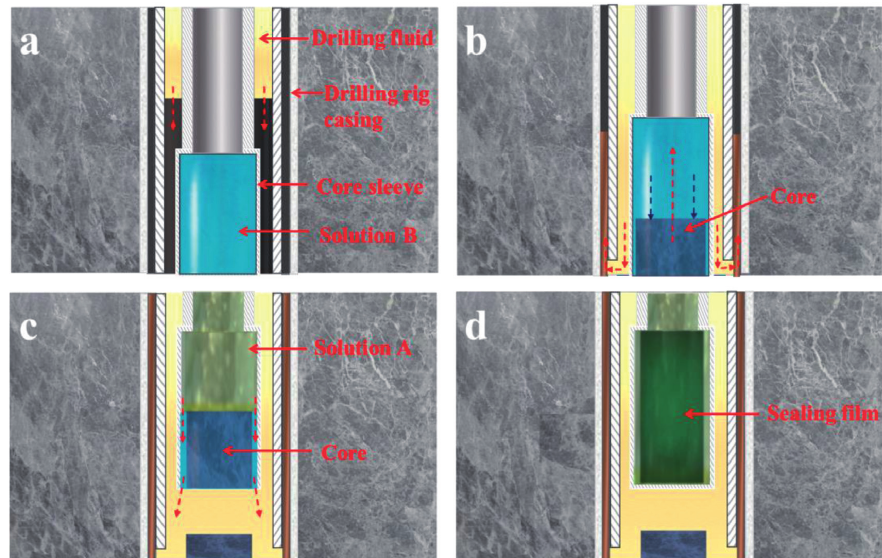
Figure 2: Schematic of the in situ crosslinking film-forming coring method: (a) drilling process; (b) before coring; (c) during coring; (d) after